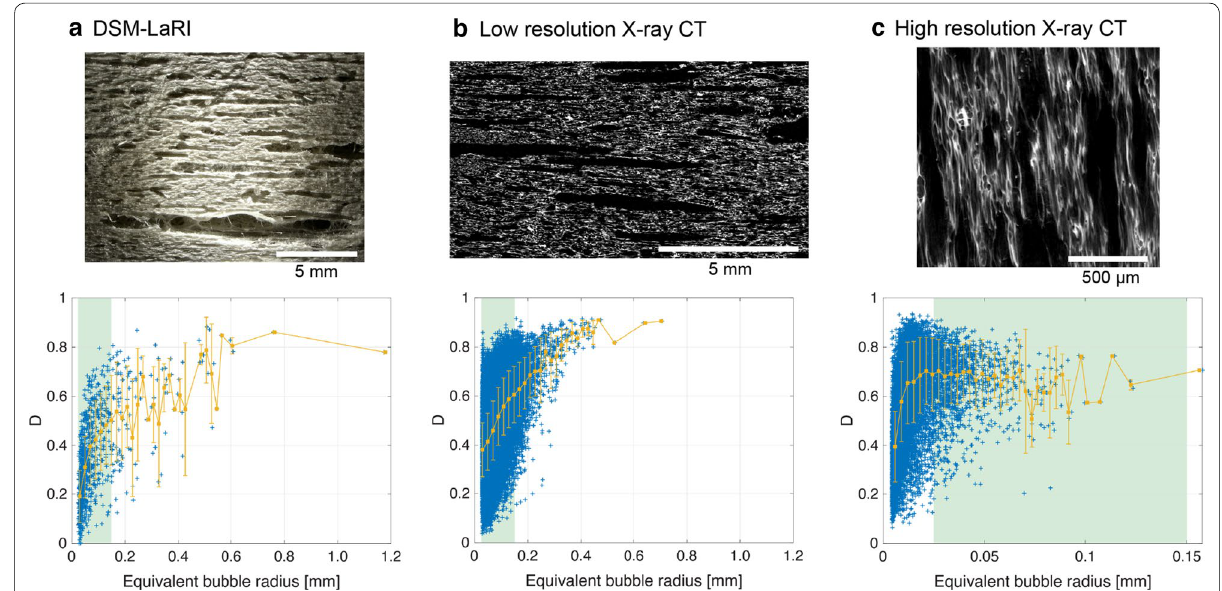
Fig. 7 Analysis results of tube pumice from Taupo ignimbrite (unit 6). The upper images are the cross-sectional images obtained with a DSM-LaRI, b the low-resolution X-ray CT, and c the high-resolution X-ray CT. The lower graphs show the equivalent bubble radius versus the bubble deformation degree. The blue crosses are all the data, and the yellow dots are the average of D with every radius interval of 2 × 10 − 2 mm for a , b and 5 × 10 − 3 mm for c . The green-highlighted area shows the range of 0.025 < R < 0.15